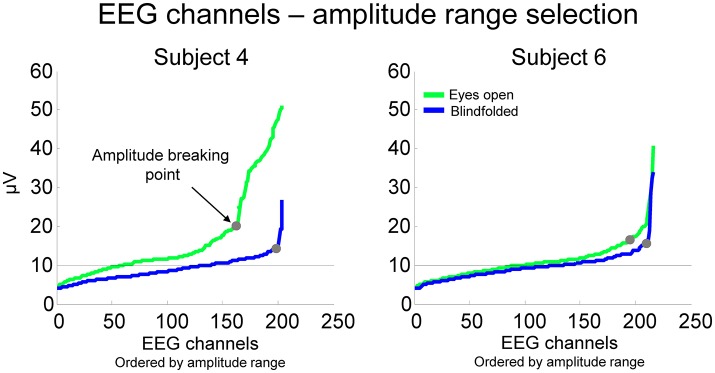
EEG amplitude range for all channels ordered from the lowest to the highest amplitude for two representative subjects while walking with the eyes open (green lines) and blindfolded (blue lines). We established that channels potentially considerable for rejection were those located at the right side of the point at which the EEG amplitude of channels start to increase substantially (breaking point).